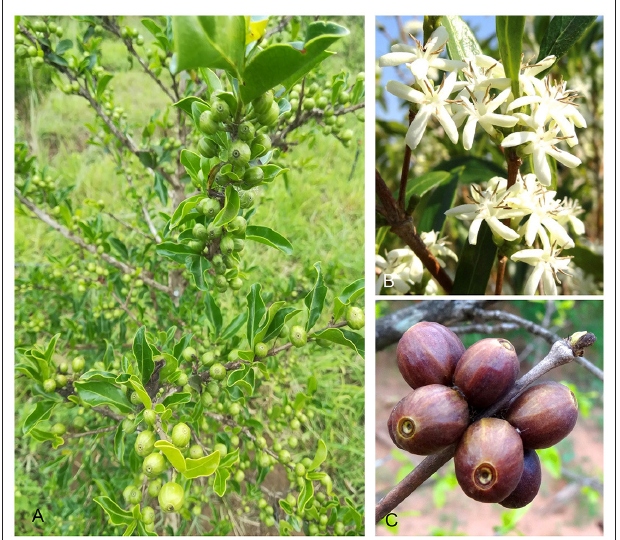
FIGURE 3 | Coffea racemosa . (A) Habit of cultivated plant, with immature fruits; (B) Flowers, mature, 5-lobed variant; (C) Fruits, approaching full maturity. Images: Charles Denison.